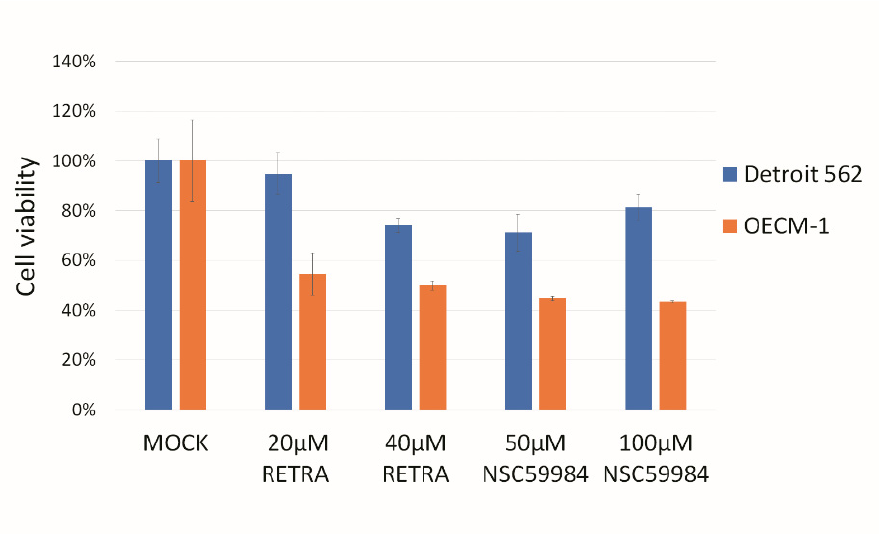
Figure 1. p73 activators can repress HNSCC growth in HNSCC cell lines. Two p73 activators, RETRA and NSC59984, were able to repress OECM-1 cell growth and, to a lesser extent, Detroit 562 cell growth. Mock was calculated as 100% to normalize for other conditions.